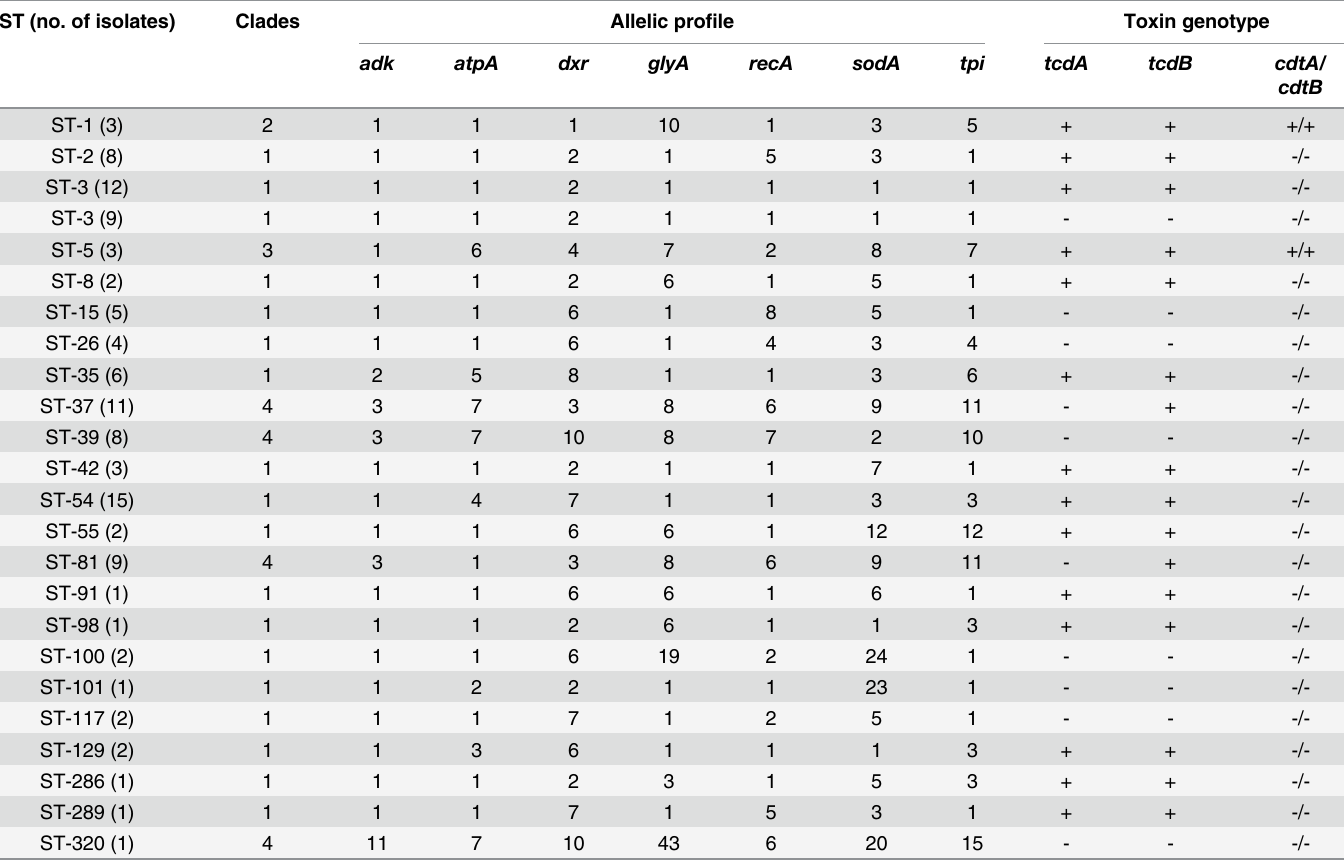
Table 2. MLST sequence types (STs), allelic profiles and toxin gene profiles of the 112 C . difficile culture positive clinical isolates. ST (no. of